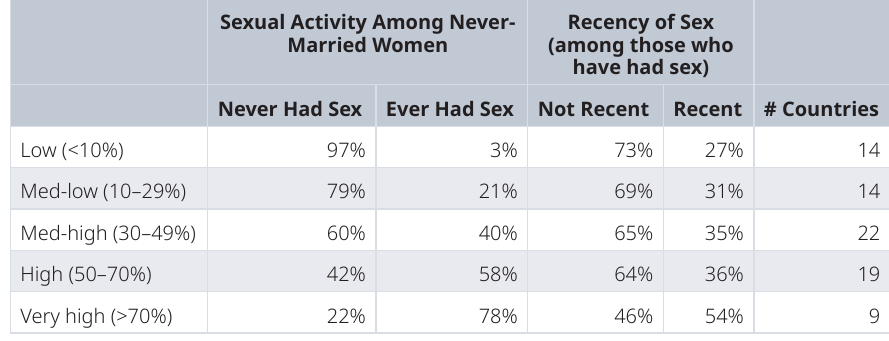
Table 2. Profiles of never-married sexual activity by